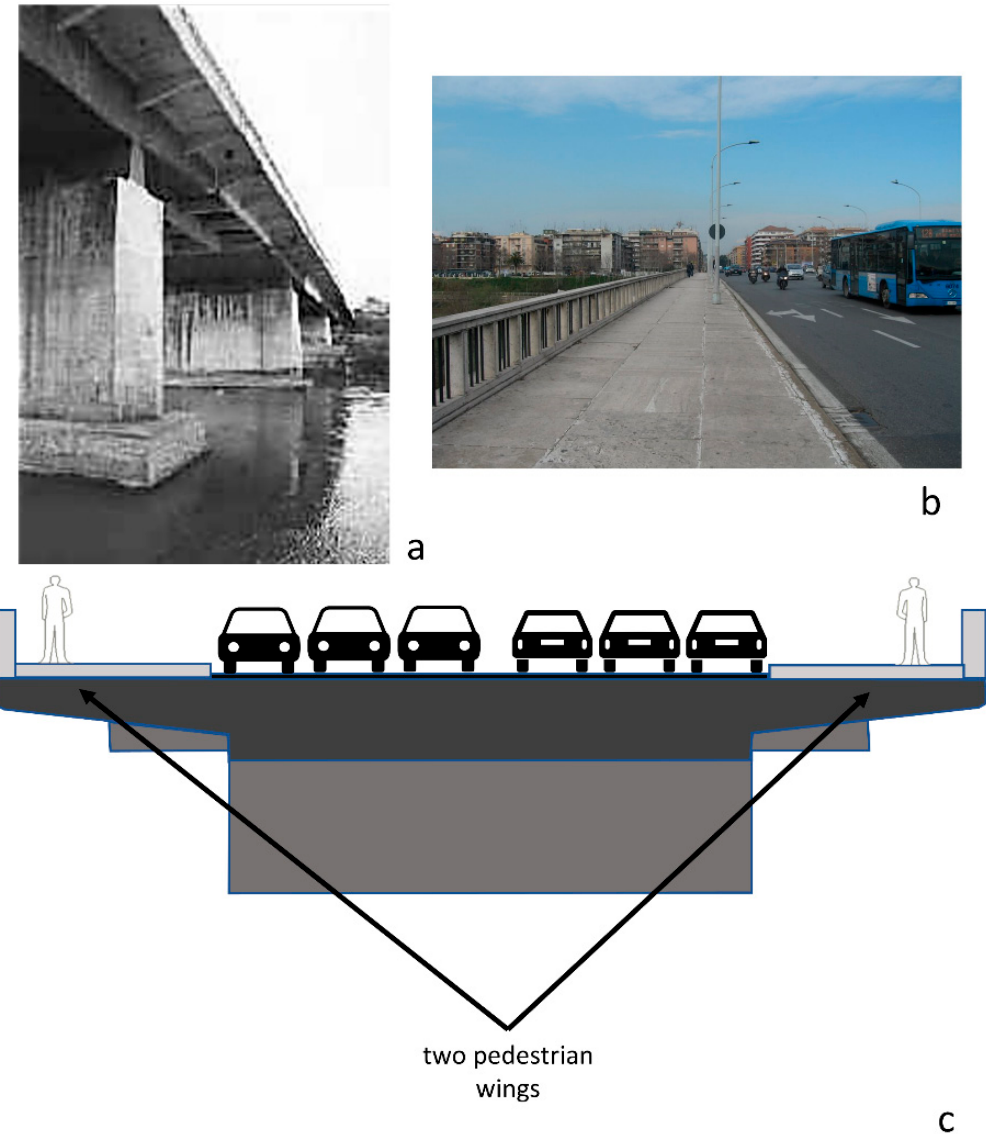
Figure 4. The Marconi Bridge on the River Tiber within the urban context of Rome ( a,c ); ( b ) The beginning of its construction after WWII (source: Google Earth).